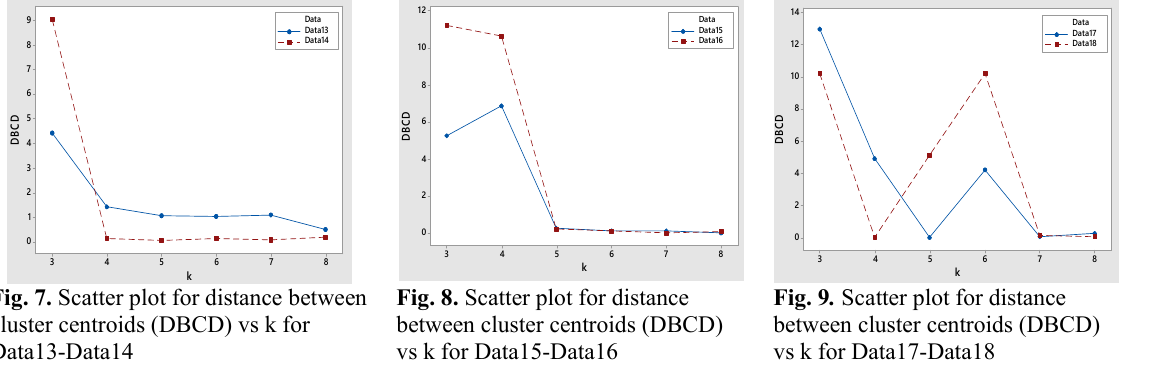
Fig. 9 . Scatter plot for distance between cluster centroids (DBCD) vs k for